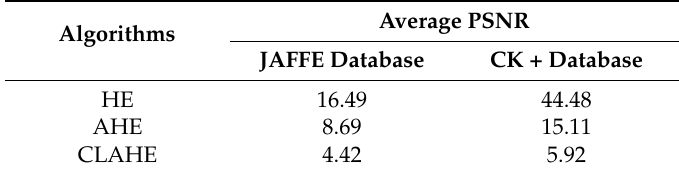
Table 2. The absolute mean brightness error (AMBE) values for different